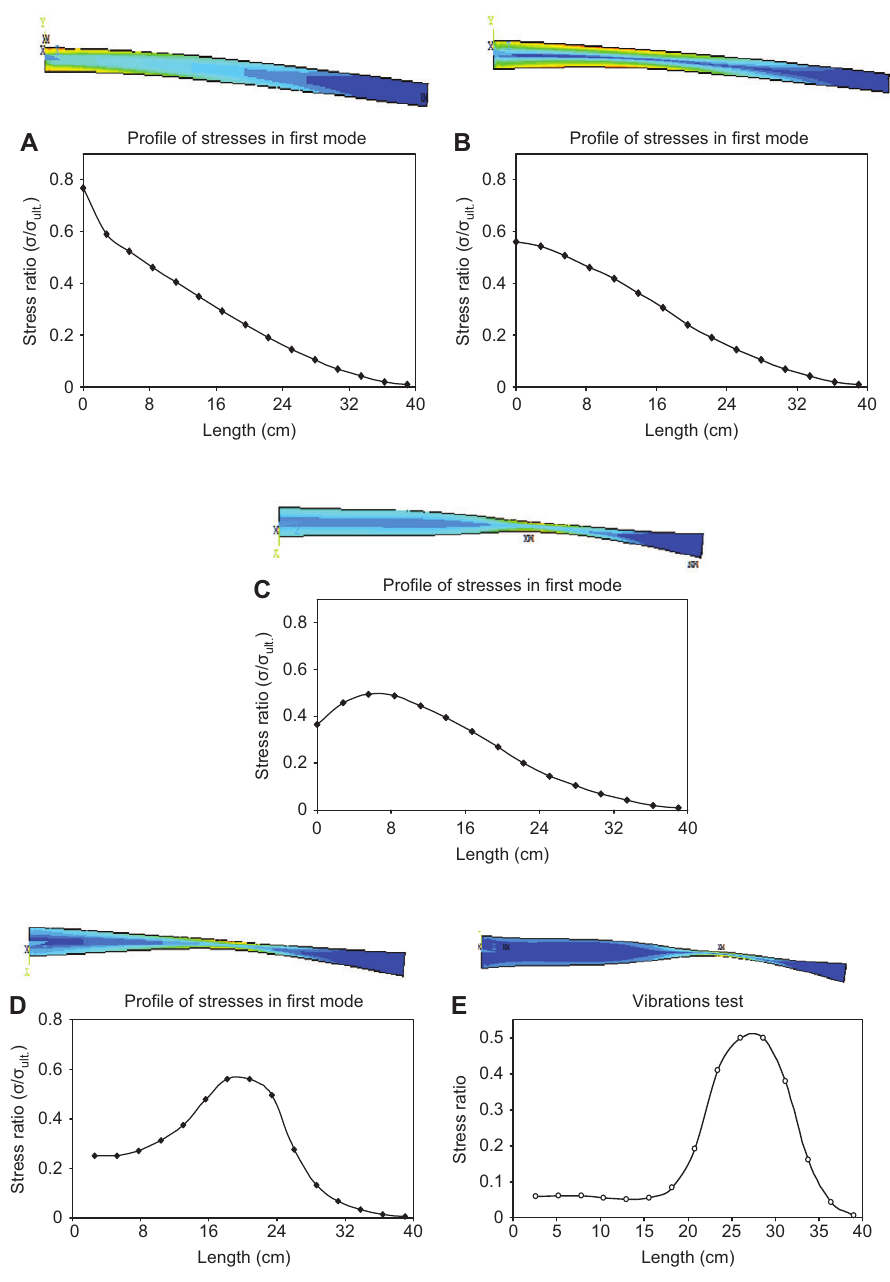
Figure 3 Geometric optimization process. (A) Initial model, (B) increasing H